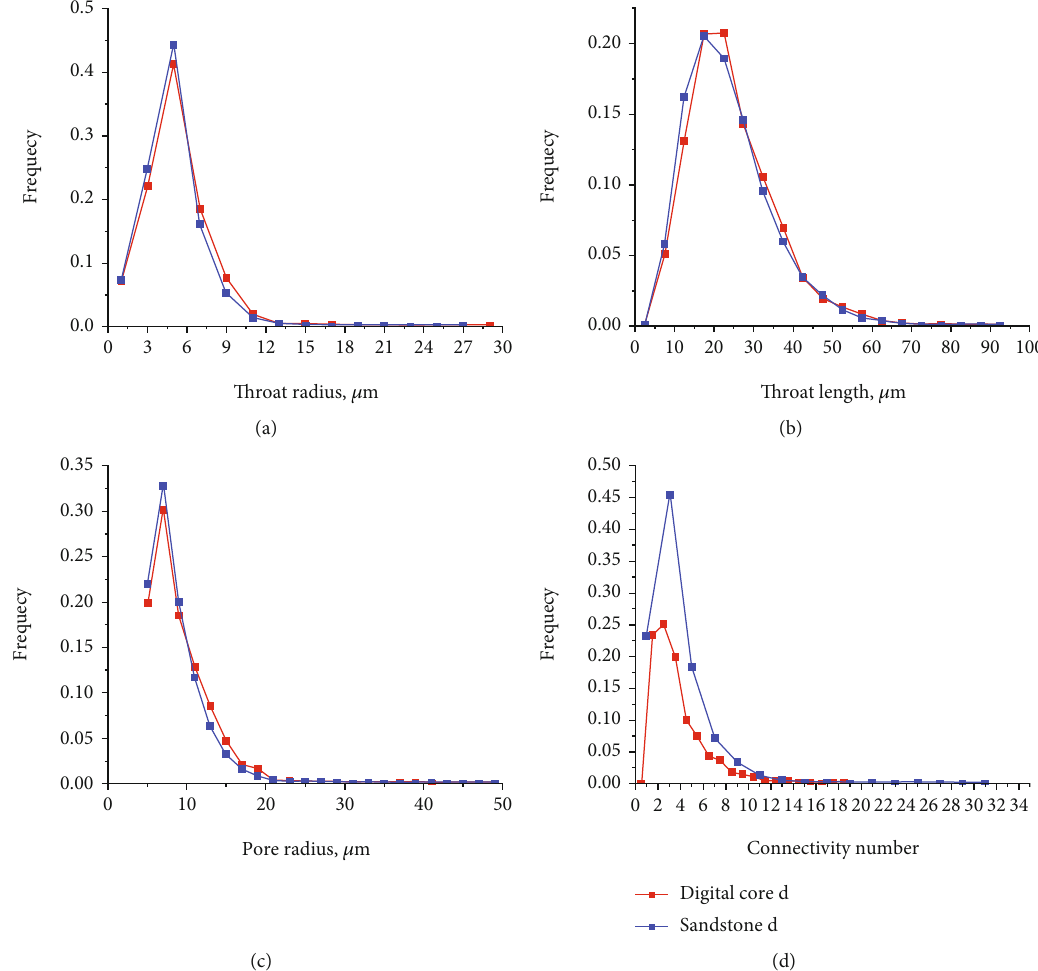
Figure 19: Pore-throat parameters of digital core d and sandstone d: (a) throat radius; (b) throat length; (c) pore radius; (d) connectivity